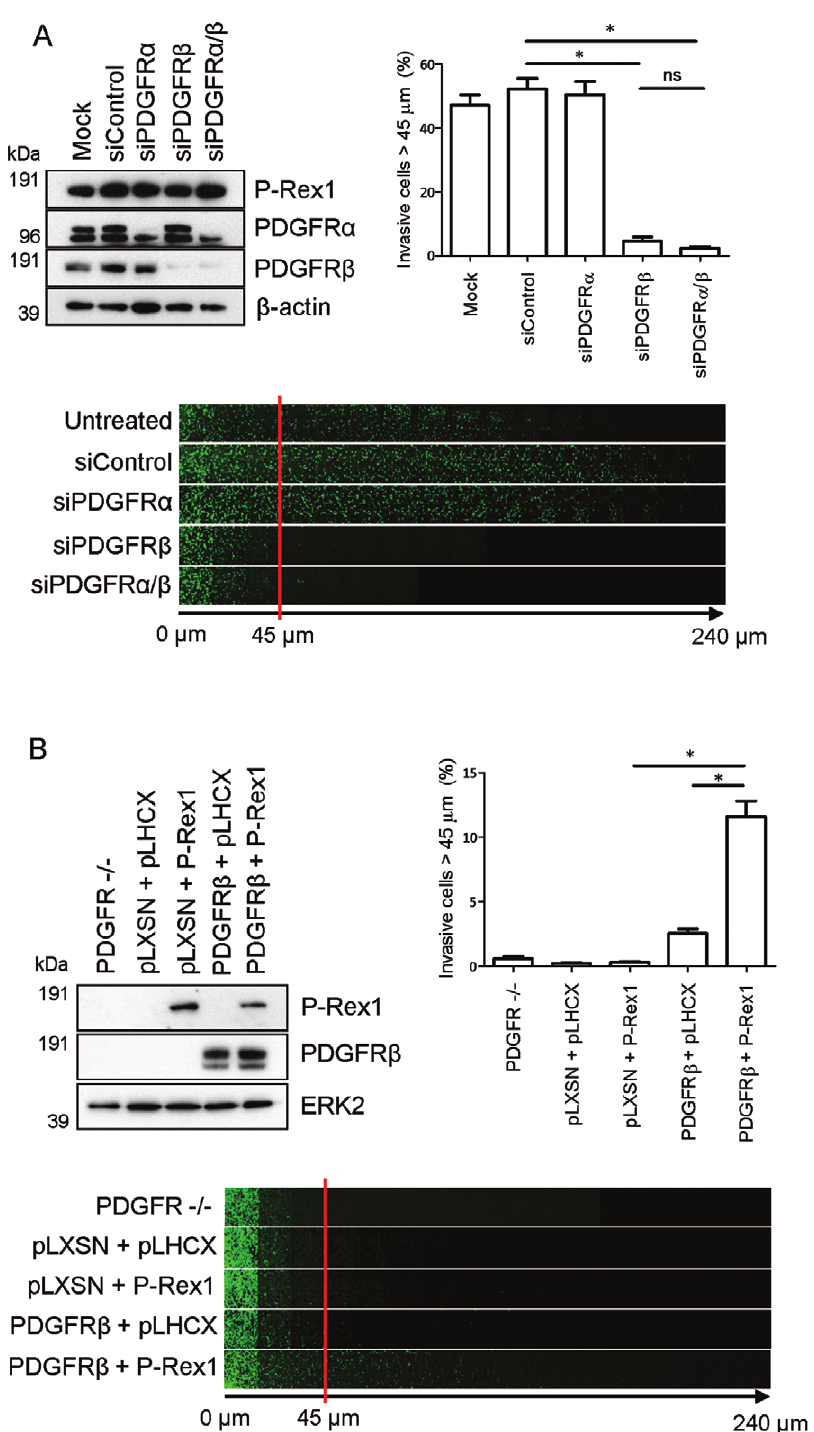
Figure 6. PDGFR b is required for invasive migration of P-Rex1 expressing human fibroblasts. (A) Invasion of P-Rex1 expressing human fibroblasts transfected with non-targeting siRNAs (siControl) or those targetting PDGFR a or PDGFR b ,either alone or in combination, was assayed and quantified as for Figure 3. (B) Embryonic fibroblasts from PDGFR a / b 2 / 2 mice were stably transfected with P-Rex1 or PDGFR b , either alone or in combination. Invasion was determined as for Figure 3. ( 6 SEM, * P , 0.05, ** P , 0.005 Mann-Whitney rank sum test, 3 independent